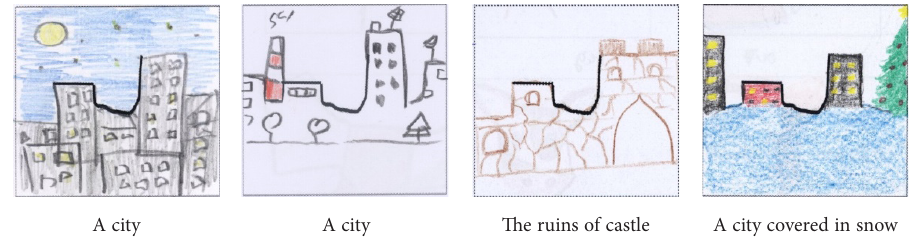
Figure 3. The creative task: interpretation of Fragment 1 – city views (source: testingmom.com, 2020) The interpreted images assigned to the group of landscapes can be divided into two groups –city (“a town”, “a district of skyscrapers”, “buildings in the distance”, “housing es- tates” and others) (Figure 3) and nature (“a river bend beside the town”, “a river bed”, “two waterfalls”, “a beach and a lake” and others) views (Figure 4).